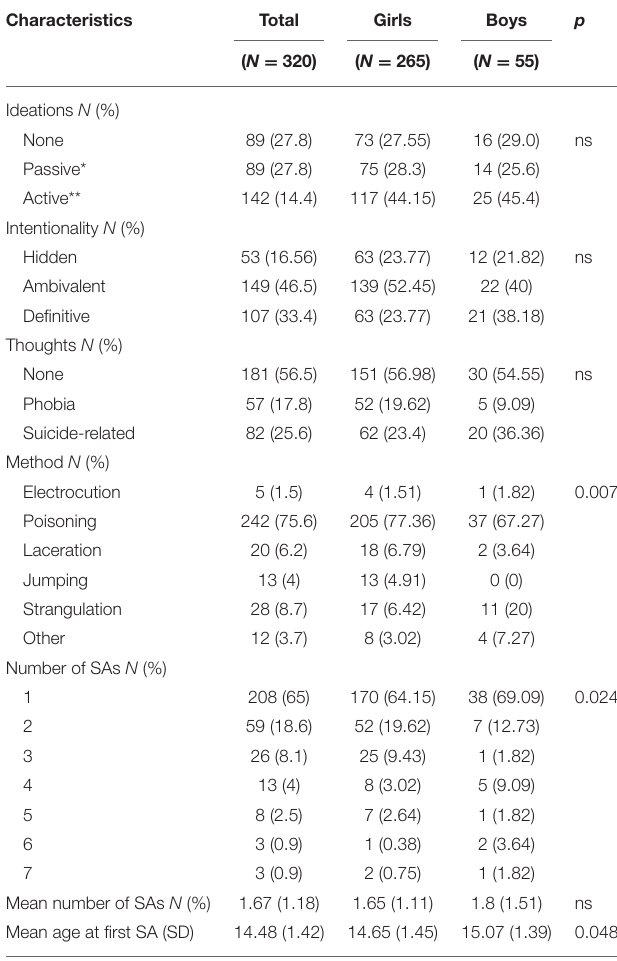
TABLE 1 | Socio-demographic characteristics and comparisons by gender. Characteristics